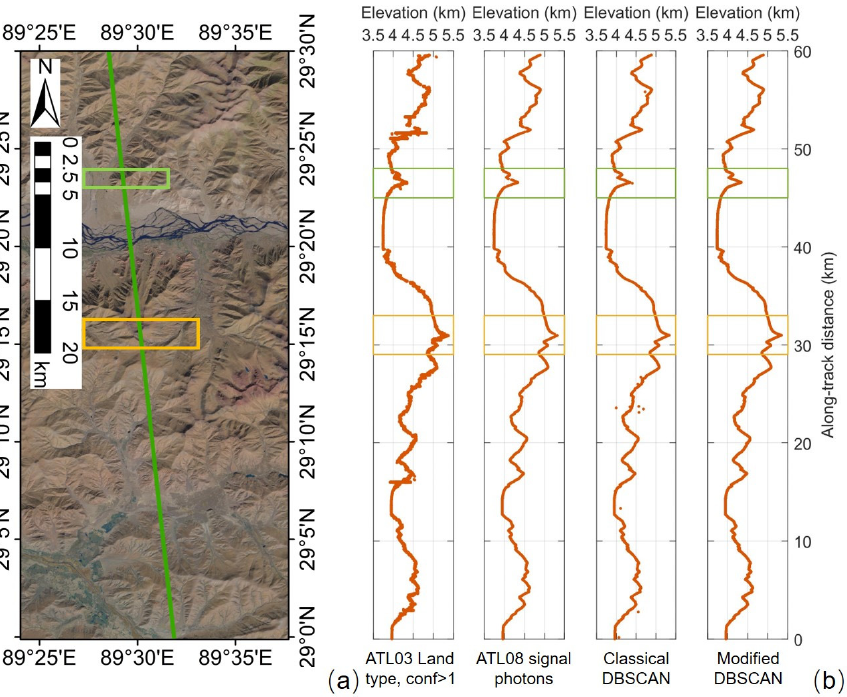
Figure 9. ( a ) ICESat-2 ATLAS ground track (from south to north or an ascending track) and satellite imagery on the Tibetan Plateau to the east of Xigaze City. The Earth’s surface is composed of bare-land and sparse grasslands, and a river in the valley. ( b ) The signal photons extracted by different methods. The columns from left to right correspond to signal photons extracted by the confidence level >1 from the ATL03 dataset, the signal photons marked in the ATL08 product, the classical DBSCAN algorithm, and the modified DBSCAN method. The diameter and threshold of the classical DBSCAN were set as 5 m and 6, respectively. Two sampled segments within the yellow and green boxes are enlarged and illustrated in Figure 10a,b, respectively. As shown in Figure 10, the blue points correspond to measured geolocated photons from the ATL03 dataset and the points marked with red are the signal photons extracted the distance from 29.5 km to 30.7 km in Figure 10a as well as from 46.2 km to 46.6 km in Figure 10b. At steep slopes, the extraction results showed significant differences. The ex- traction result based on the confidence level from the ATL03 dataset mistakenly classified many noise photons as signal photons. Moreover, several breakpoints existed (i.e., many signal photons are missed), for example, near 31 km, which corresponded to the largest slope as in Figure 10a. For the classical DBSCAN method, it had to increase the threshold value (i.e., Minpts ) to refrain from a massive amount of noise photons that were wrongly classified as signal photons, but it simultaneously made the extraction result inconsecu- tive in steeper areas, which was similar to the results from the ATL08 product. In the other three study areas, comparisons similar to those in Figures 9 and 10 were conducted. The